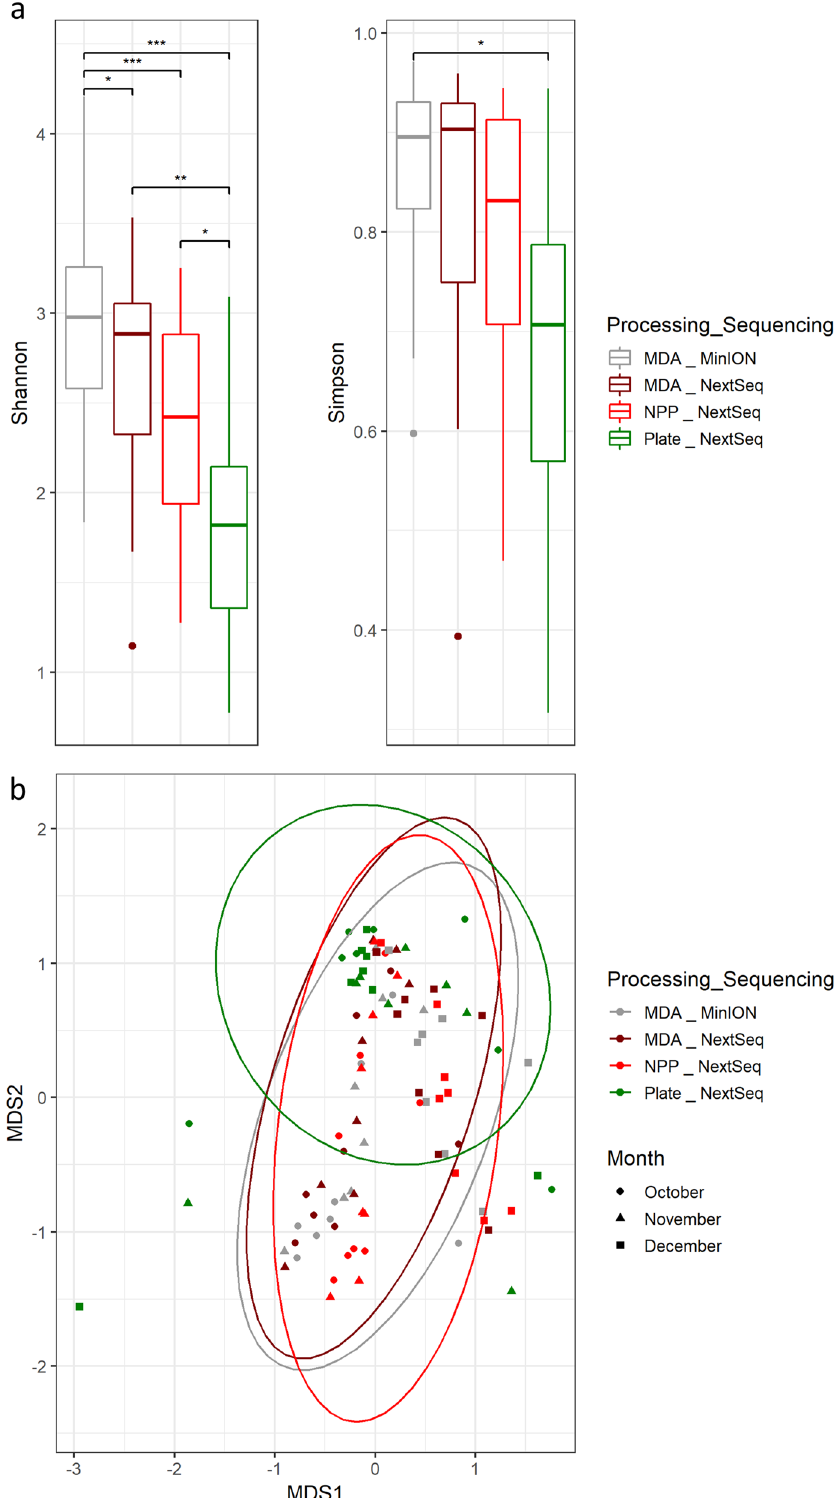
Fig. 4 Diversity analysis. a Shannon and Simpson alpha diversity analysis. b Bray Curtis multidimensional scaling (MDS) beta diversity analysis. Boxplot centre line, median; box limits, upper and lower quartiles; whiskers, ×1.5 interquartile range; points, outliers (*** = p < 0.001, ** = p < 0.01, * = p < 0.05). Controls are excluded from these calculations and fi gures. MDA MinION, refers to samples whose DNA was subject to MDA before sequenced on an Oxford Nanopore MinION sequencer. MDA NextSeq, refers to samples whose DNA was subject to MDA before sequenced on a Illumina NextSeq sequencer. NPP NextSeq, refers to samples whose DNA had no pre-processing (NPP) in terms of ampli fi cation before sequencing on an Illumina NextSeq sequencer. Plate NextSeq, refers to samples whose metagenomic DNA was extracted from easily cultured microorganisms before sequencing on an Illumina NextSeq